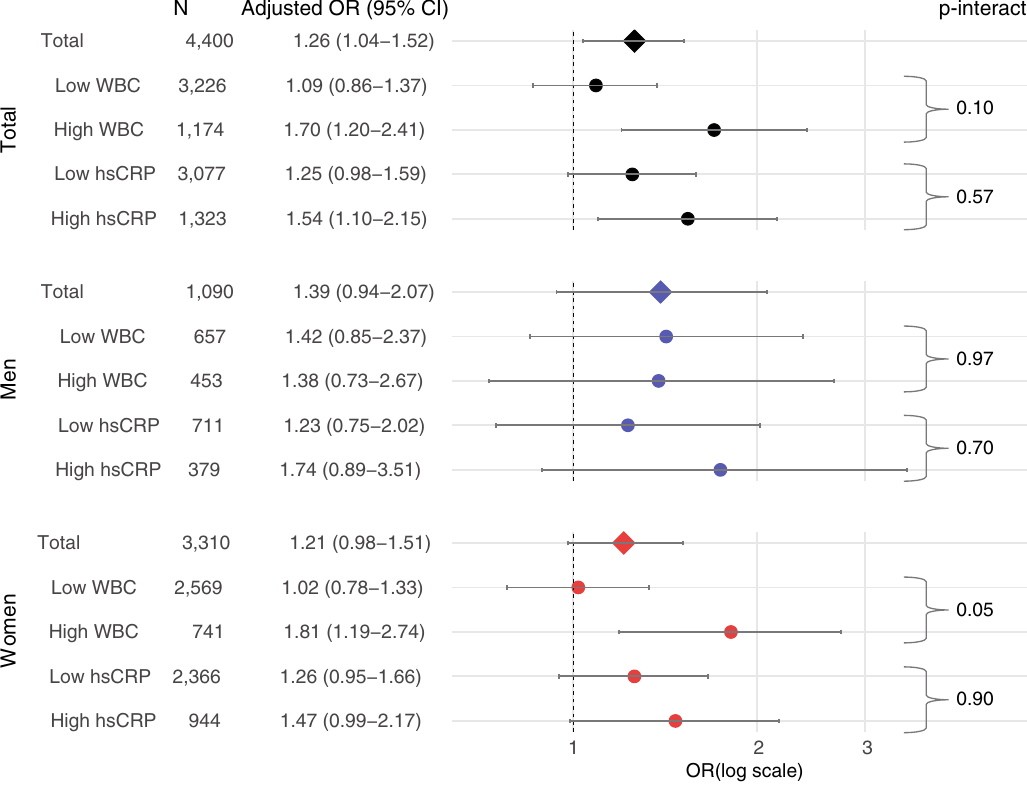
Figure 1. Association between NAFLD and cognitive impairment stratified by the inflammatory status. NAFLD was defined as FLI ≥ 30, and cognitive impairment was defined as MMSE < 24. Each model was adjusted for sex, age, household income, marital status, current drinking status, current smoking status, diabetes, and hypertension. Low WBC: WBC < 75th %tile (6300/μL), High WBC: WBC ≥ 75th %tile (6300/μL). Low hsCRP: hsCRP < 1·0 mg/L, high hsCRP: hsCRP ≥ 1·0 mg/L. NAFLD, non-alcoholic fatty liver disease; WBC, white blood cell; hsCRP, high-sensitivity C-reactive protein; OR, odds ratio; CI, confidence interval; FLI, fatty liver index; MMSE, Mini-Mental State